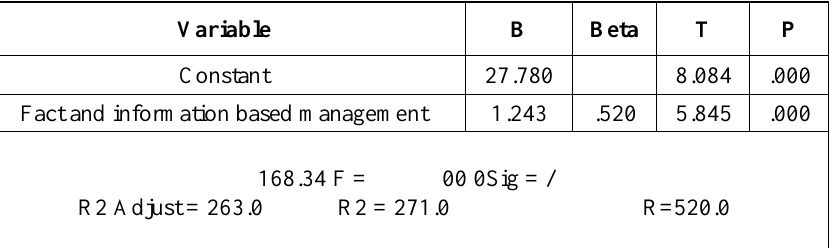
Table 2 . Results of regression analysis for the first hypothesis Variable